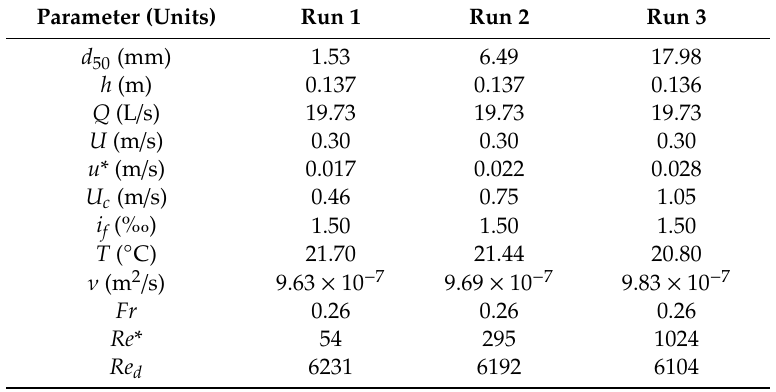
Table 1. Hydraulic parameters of the experimental runs for the approaching flow.